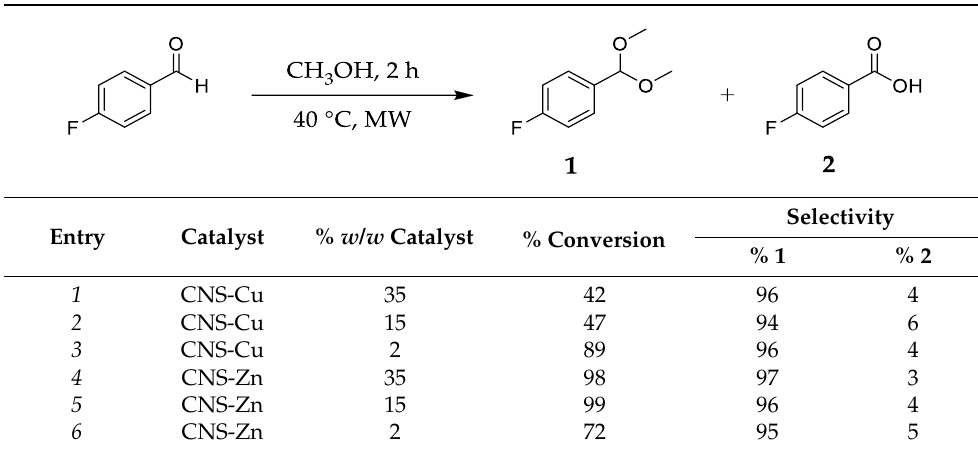
Table 4. Optimization of the % w / w of CNS-Cu and CNS-Zn a .